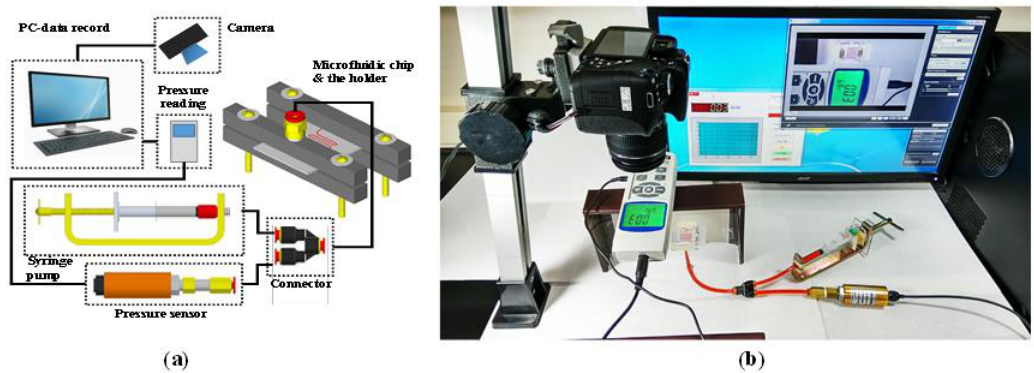
Figure 8. Proprietary system used to perform burst tests to characterize bonding strength: ( a ) schematic diagram of testing system; and, ( b ) actual system used in experiments.